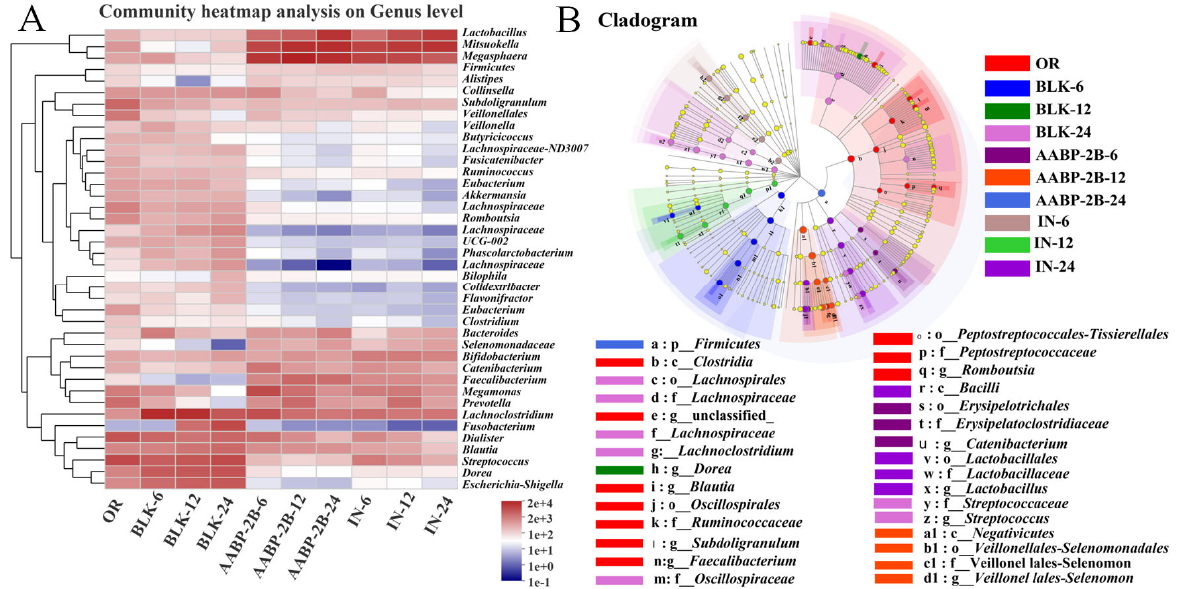
Figure 10. The heatmap analysis of the relative abundance at the genus level ( A ). The linear discriminant analysis effect size (LefSe) analysis in the comparison of gut microbiota among OR, BLK, AABP-2B, and IN control group ( B ). OR, original faeces group; BLK, without-carbon-source group; AABP-2B, indigestible A. asphodeloides polysaccharide (AABP-2B)-treatment group; IN, inulin-treatment group.